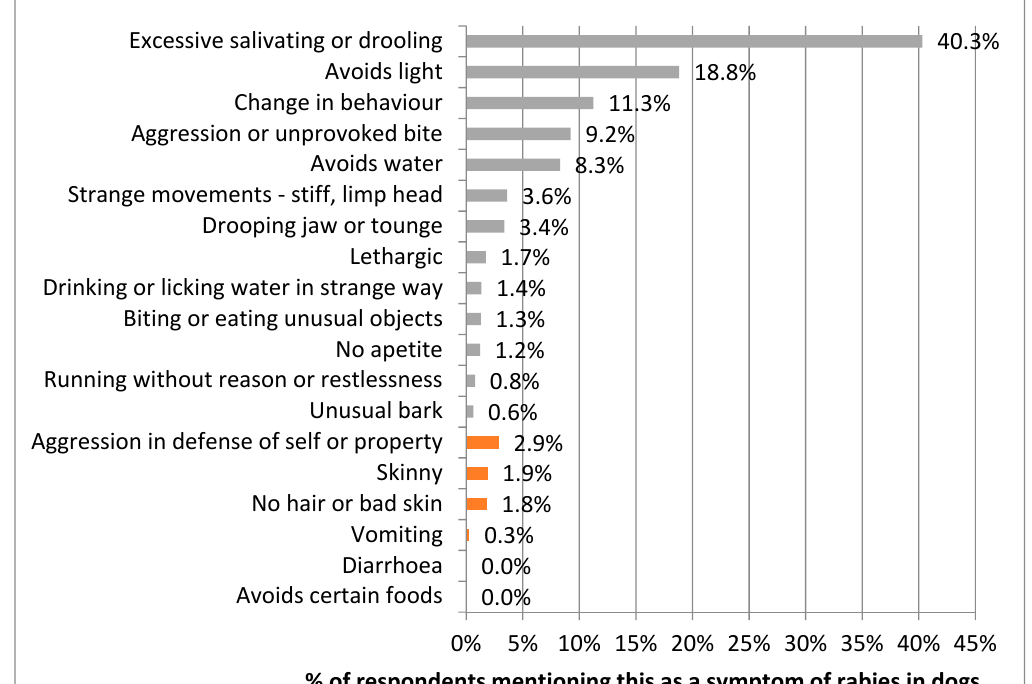
Figure 13. Respondents’ responses to the question of what are the appropriate actions following a bite from an unknown dog; correct actions are in green, potentially risky actions are in red.